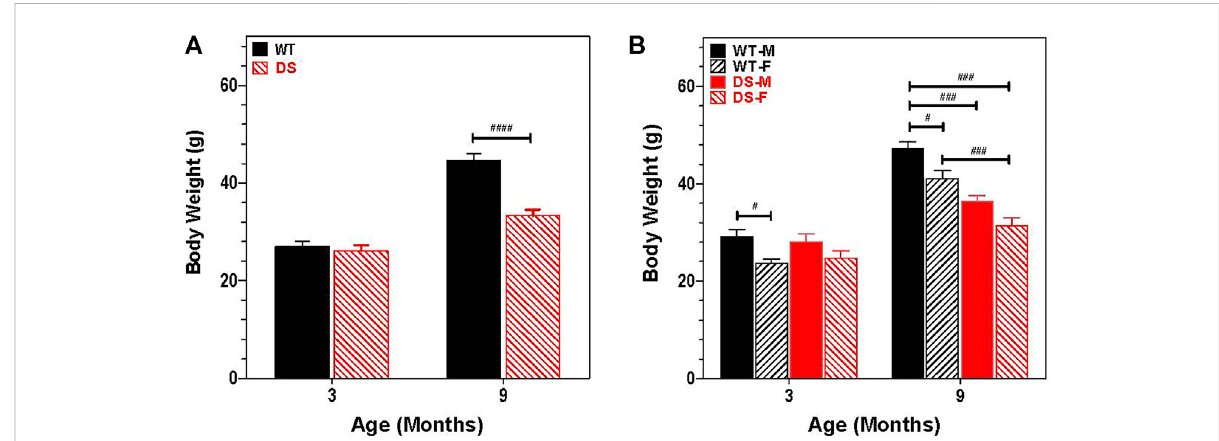
FIGURE 2 Increase in body weight is age and gender dependent. (A) Increases in body weight between 3 and 9 months of age is signi fi cantly less in DS mice than WT. Mean body weight (g) (+SEM) of WT and DS mice similar at 3 months of age, but at 9 months of age, DS mice weigh signi fi cantly less than WT mice. #### p < 0.0001). (B) Increase in body weight between 3 and 9 months of age is gender dependent. Two way repeated measure analysisofvariancerevealedasigni fi canteffectofgenotype(F3,26=10.35, p < 0.0001;age(F1,26=599.49, p <